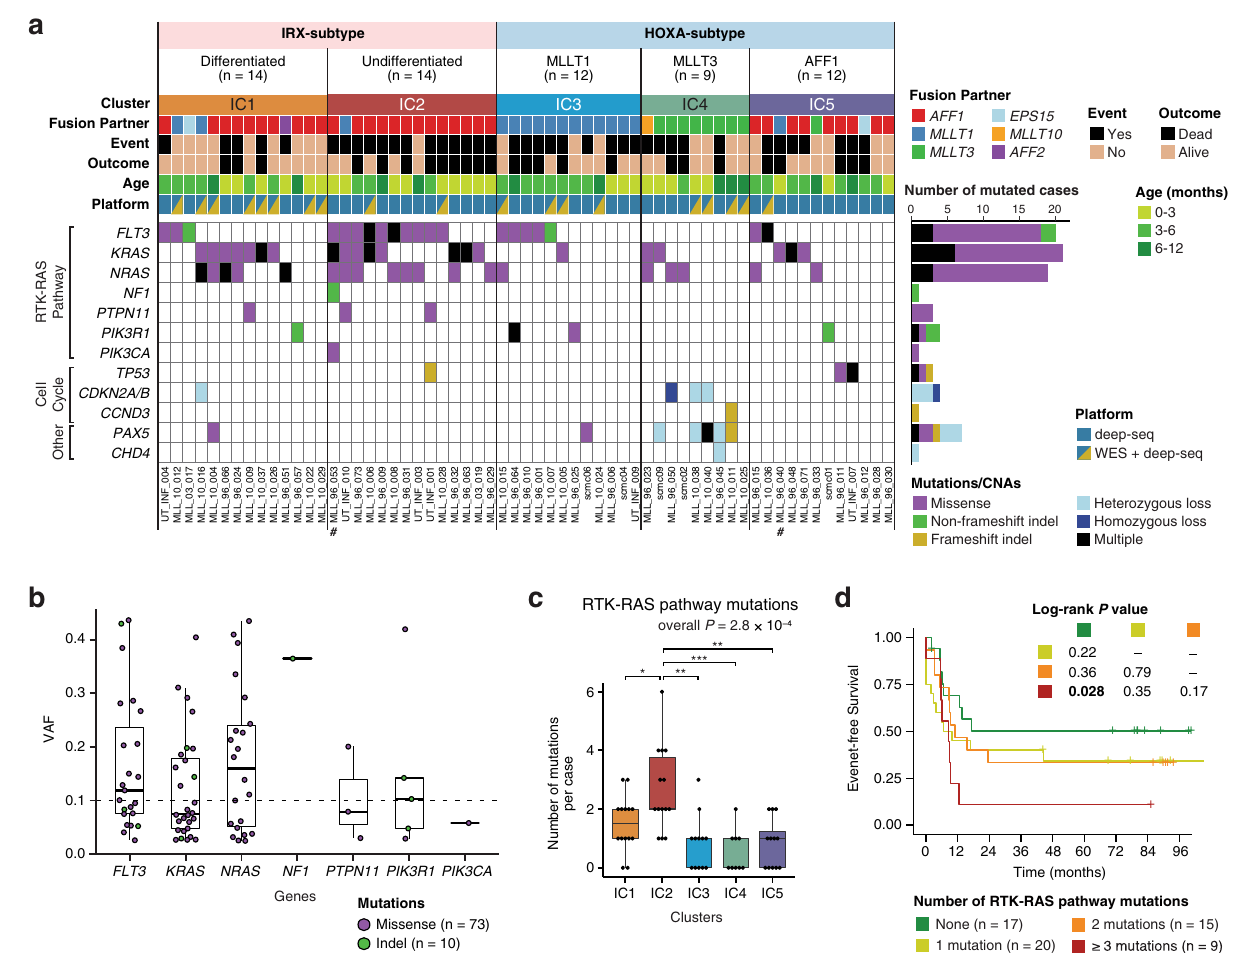
Fig. 4 | Mutational landscape of KMT2A -r infant ALL subgroups. a Gene muta- tions and CNAs in the different subgroups of KMT2A -r infant leukemia. Number signs (#) indicate the two cases with B/M MPAL. b VAFs of RTK-RAS pathway mutations detected with deep-seq. The VAF of 0.1 is indicated by a dashed hor- izontalline.Boxplotsshowmedianand fi rst/thirdquartiles. c Numberofmutations intheRTK-RASpathwaypercase.All61casesof thediscoverycohortareincluded: